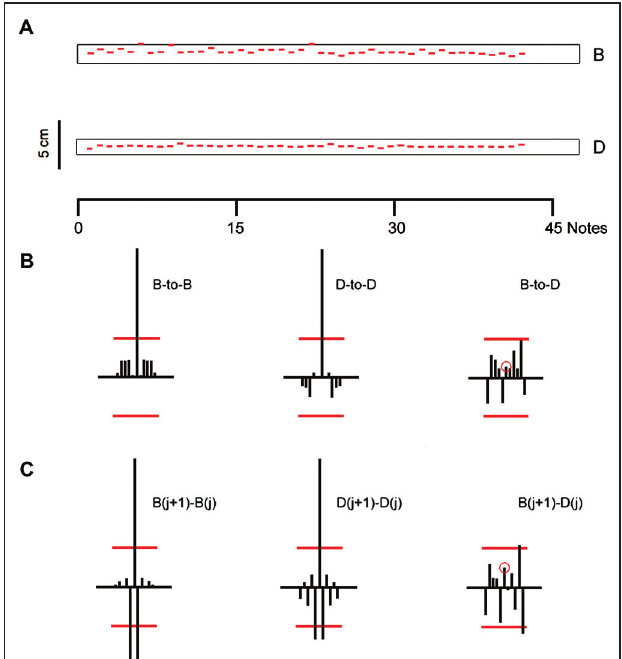
FIGURE 1 | (A) Subject shifts between two notes (top trace: note B; lower trace: note D) while using the bow. The two traces show the sequential modal values of finger contact position as measured by a string circuit. The modal location (vertical axis) for each note is shown as a standardized line and plotted horizontally against the note number. Enclosing each note sequence is a “pitch window”; notes within that window would not be perceived as having pitch error. (B) Serial correlation coefficients for the note sequences shown above. The red lines indicate the values within which coefficients are not significant at the p < .05 level. Left: serial auto-correlation coefficients for Note B, lags − 5 to + 5. Middle: same for note D. Right: cross-serial coefficients with note B the reference note. The red circle indicates the value at lag = 0. (C) Serial correlation coefficients for the sequential differences between notes. Left: Serial auto-correlation coefficients for the sequential differences between notes B. Middle: same for note D. Right: cross-serial correlations between sequential note B and note D